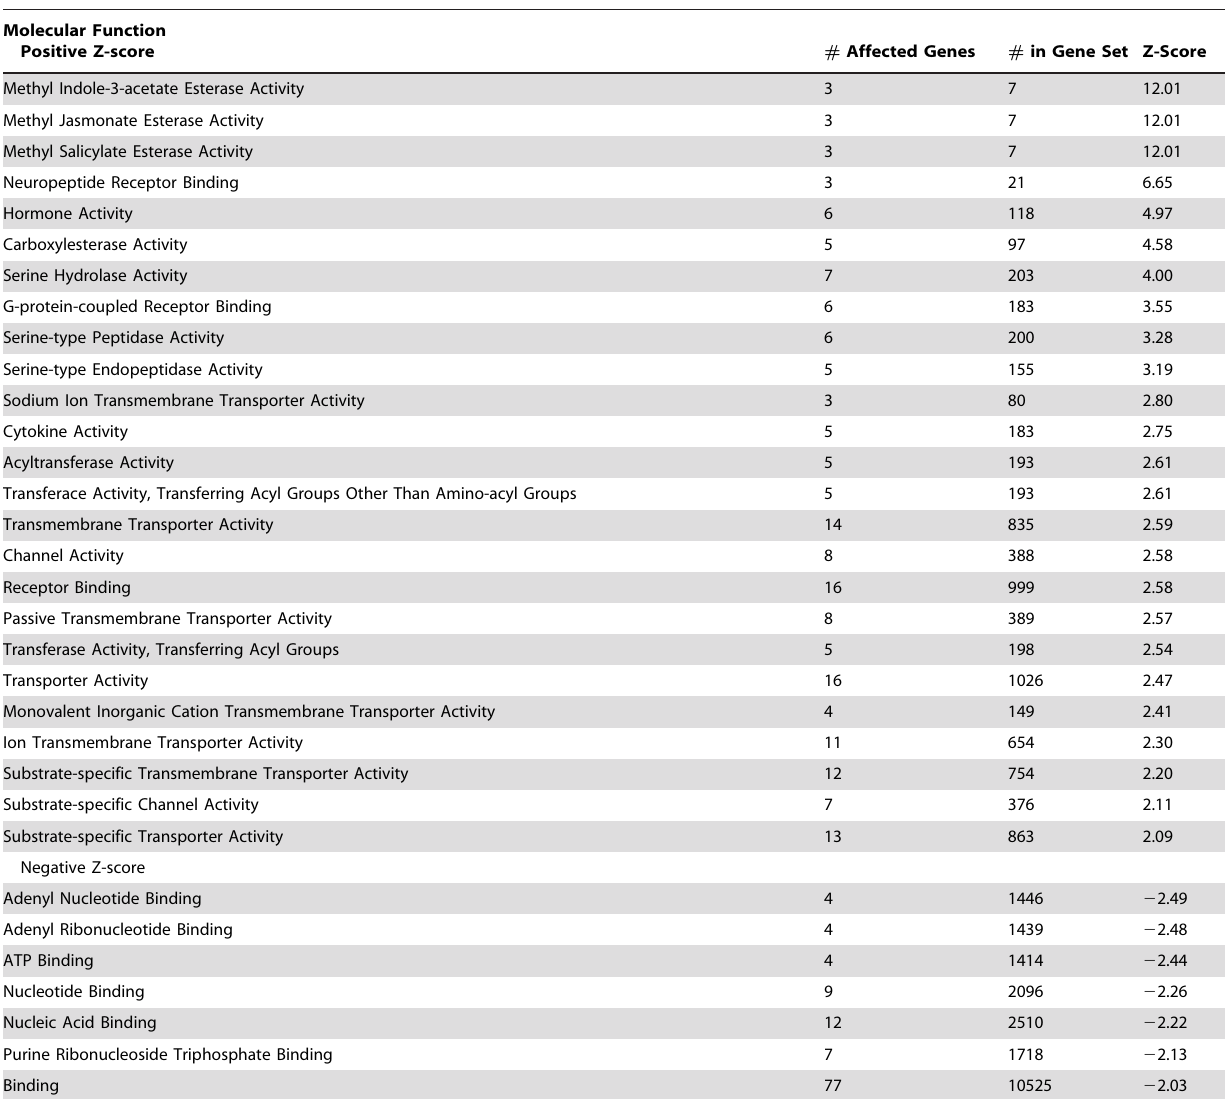
Table 4. Changes in Brain Expression with CCI and mHW: Molecular Function.